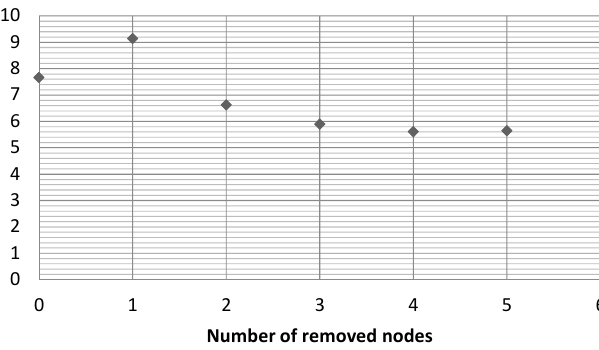
Figure 20. The change of the average path length in the graph.